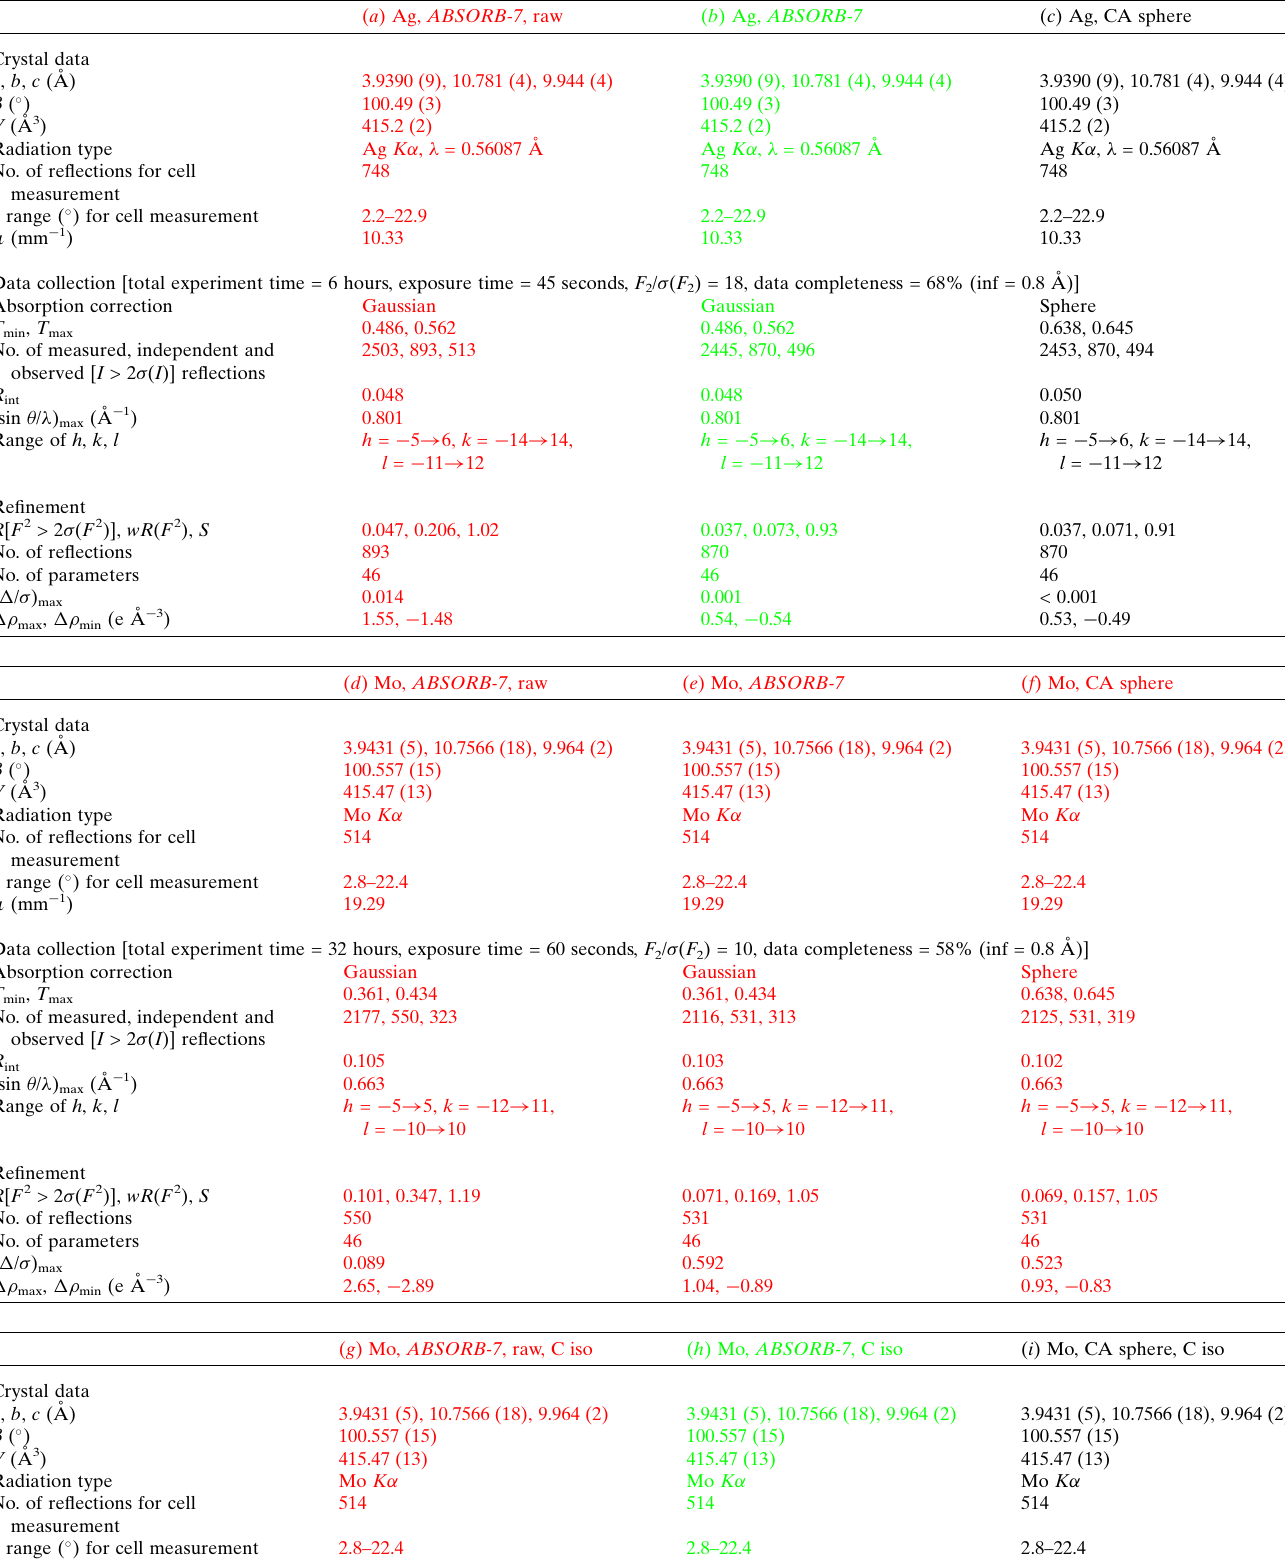
Table 2 Experimental details. For all structures: C 6 H 2 Br 4 , M r = 393.72, monoclinic, P 2 1 / n , Z = 2. Experiments were carried out at 293 K. Crystal size 0.18 (cid:3) 0.07 (cid:3) 0.01 (mm). H-atom parameters were constrained. Refinements not acceptable for publication (incorrect) are highlighted in red, preferable in green, and those publishable but not always preferable are not